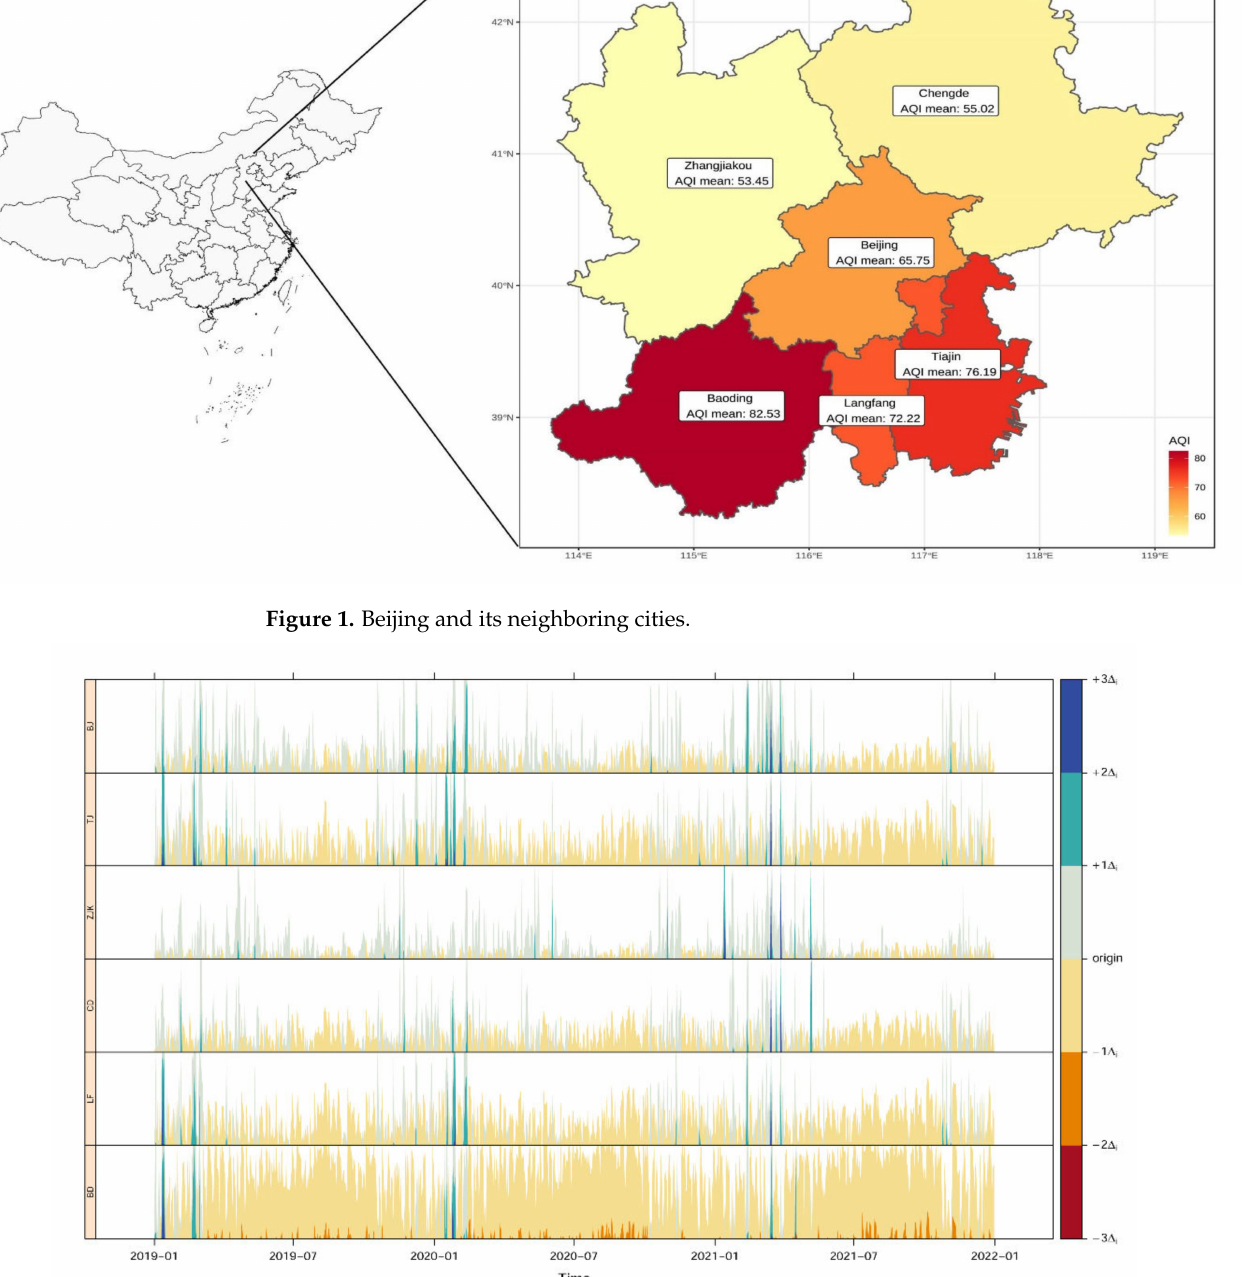
Figure 2. Variation of air quality index ( AQI ) in Beijing and its neighboring cities. Note: cool color denotes the extent to which AQI increases and warm color denotes the extent to which AQI